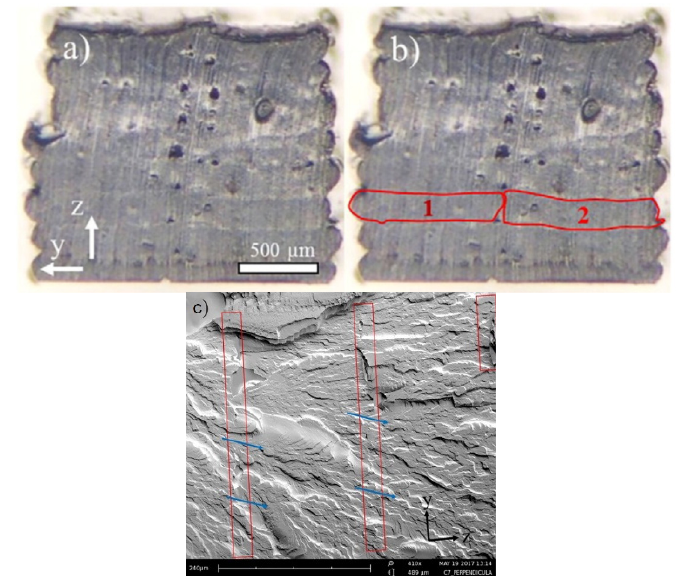
Figure 5. SEM images of ( a ) cross-section, ( b ) cross-section with highlighted layers in the y -direction and ( c ) showing the y-z view of the interlayer bonds. Adapted with permission from Ref. [69]. 2017, Elsevier.